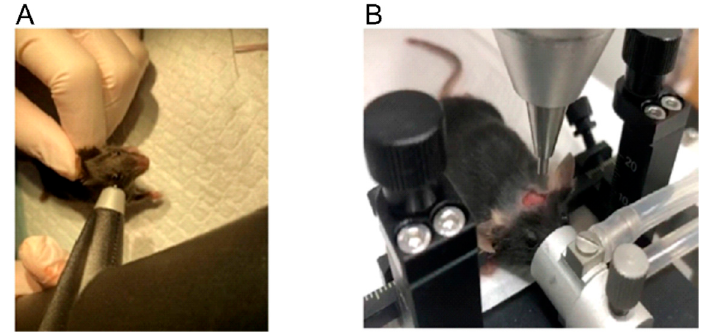
Figure 1. IOP measurement in mice ( A ). The placement of mice before impact ( B ).